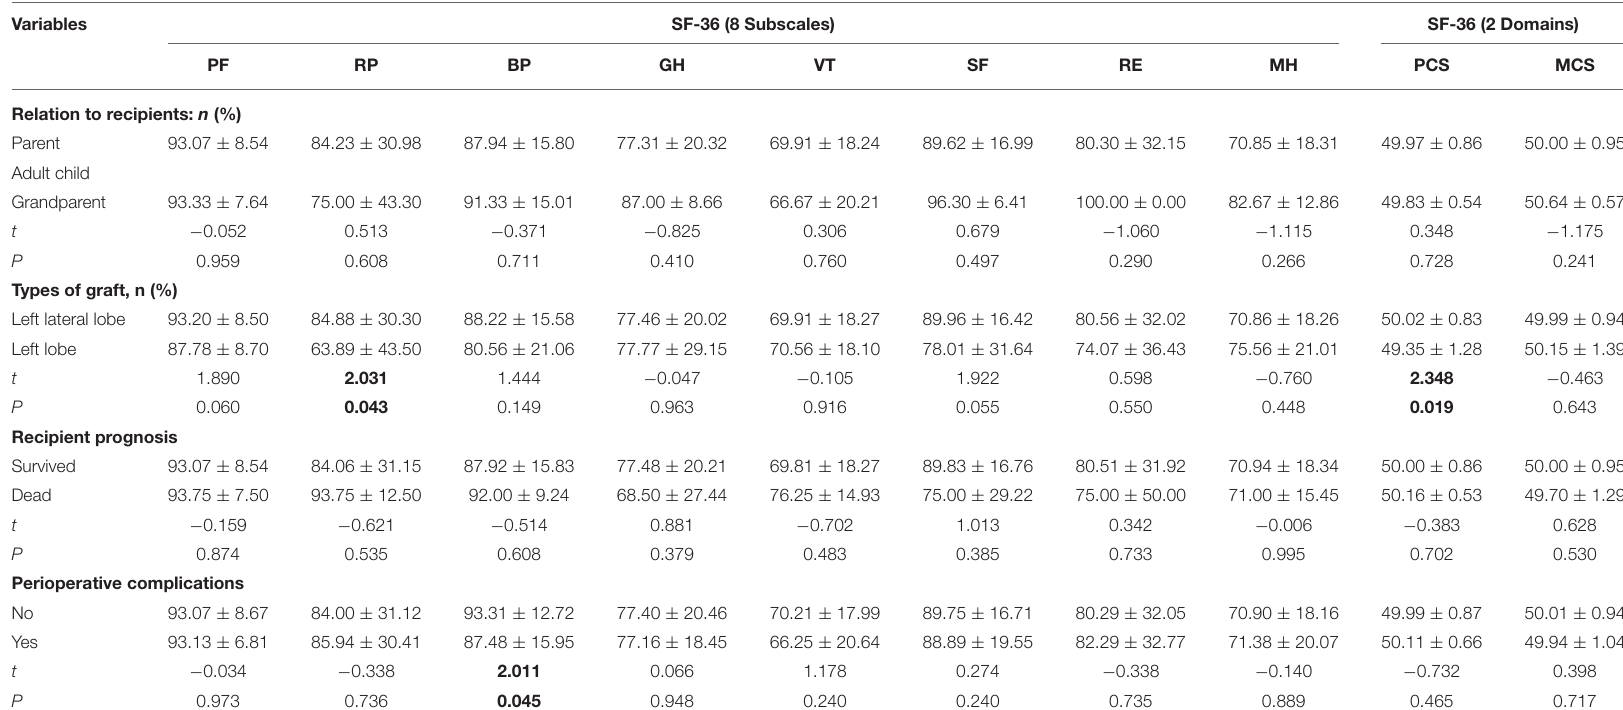
TABLE 5 | The score of each subscale and two summary domains in SF-S6 for different clinical groups.